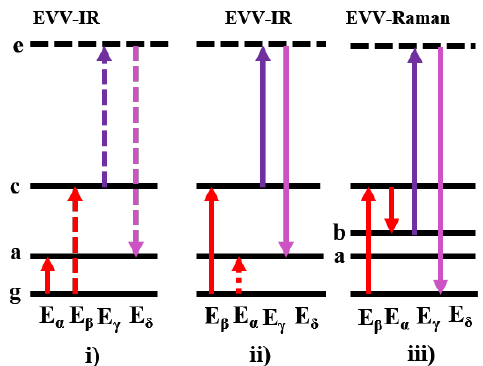
Figure 9. Three coherent pathways contributing to the EVV-2DIR signal, labeled as i )– iii ). Here, g denotes ground state, a and b denote vibrational states, c denotes their combined state and e denotes virtual electronic state. ω α and ω β are always pulses 1 or 2 and defined such that ω β > ω α . The pathway ( i ) is for ω α arrive at the sample first, and the pathways 2 and 3 are for ω β arriving first. Solid arrows show ket transition and dotted arrows show bra transitions.